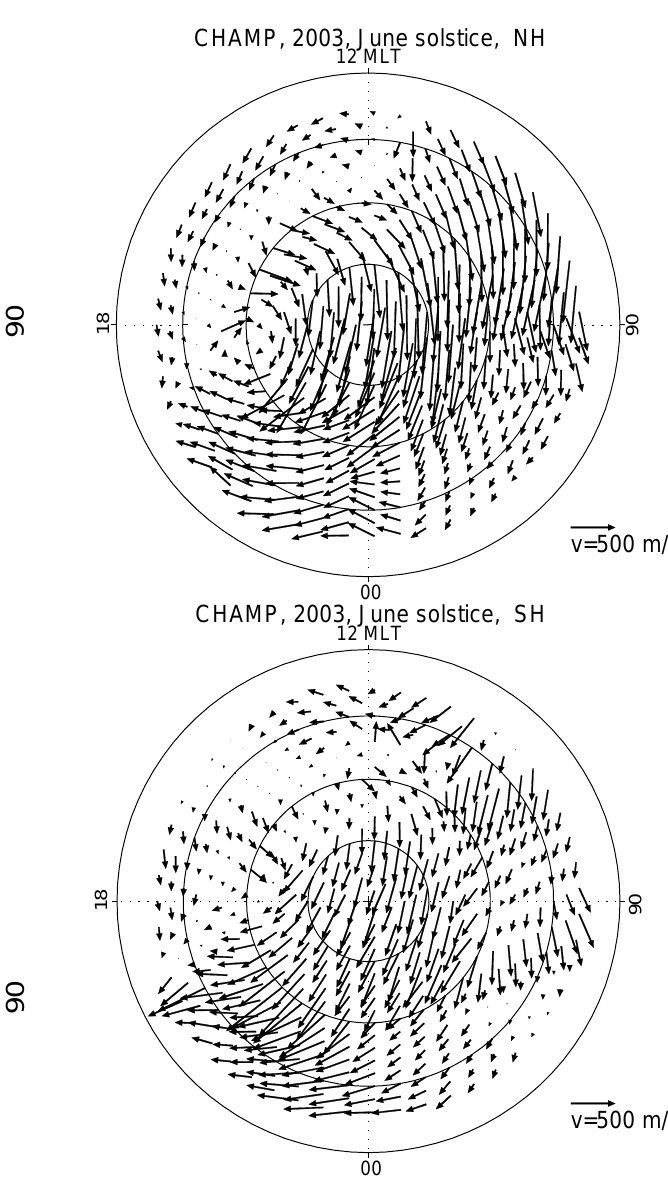
Fig. 4. Distribution of mean thermospheric wind vectors in the Northern (summer) (top) and Southern (winter) (bottom) Hemi- sphere for June solstice conditions. The vectors are recovered from multiple single component wind